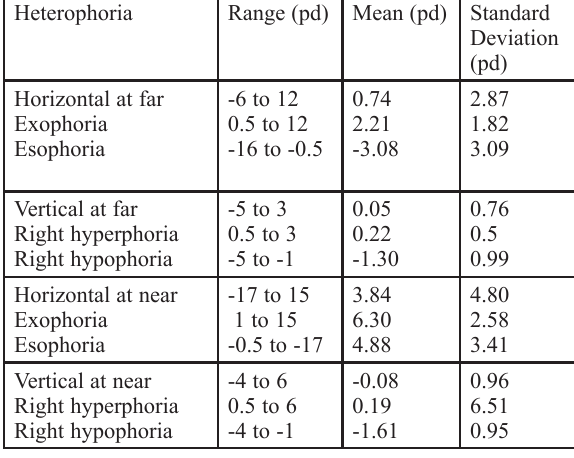
Table 1. A summary of heterophoria measurements. Positive values refer to exophoria and right hyperphoria while nega- tive refer to esophoria and right hypophoria. The units are in prism diopters (pd).